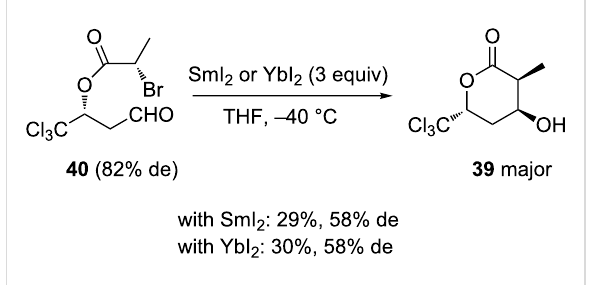
Scheme 16: Synthesis of β -hydroxy- α -methyl- δ -trichloromethyl- δ - valerolactone through a Sm(II)- or Yb(II)-mediated Reformatsky